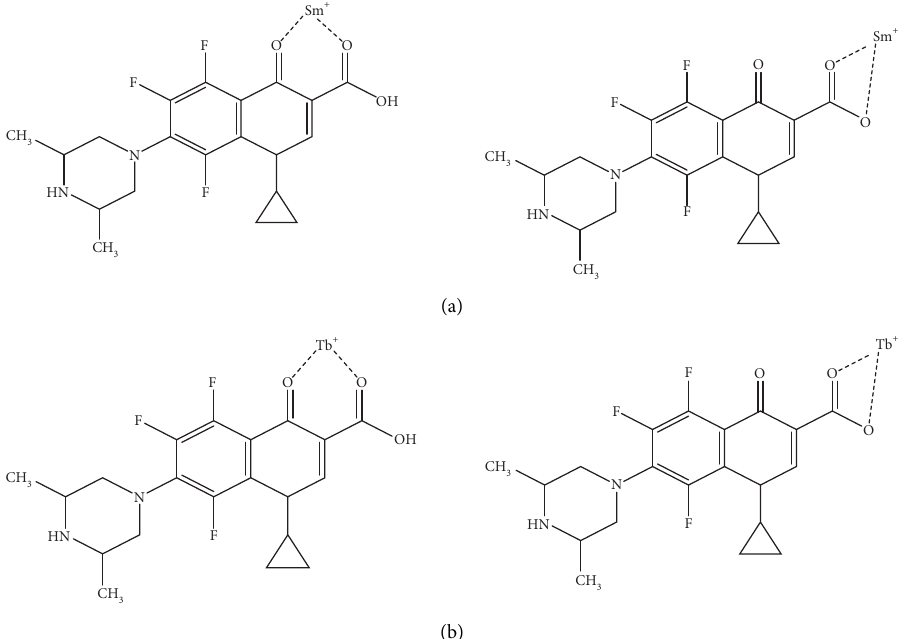
Figure 7: Proposed structure of the ORLX-Sm(III) complex (a) and ORLX and ORLX-Tb(III) complex (b). Table 6: Analytical parameters for the determination of ORLX via complexation with Sm(III) and Tb(III).